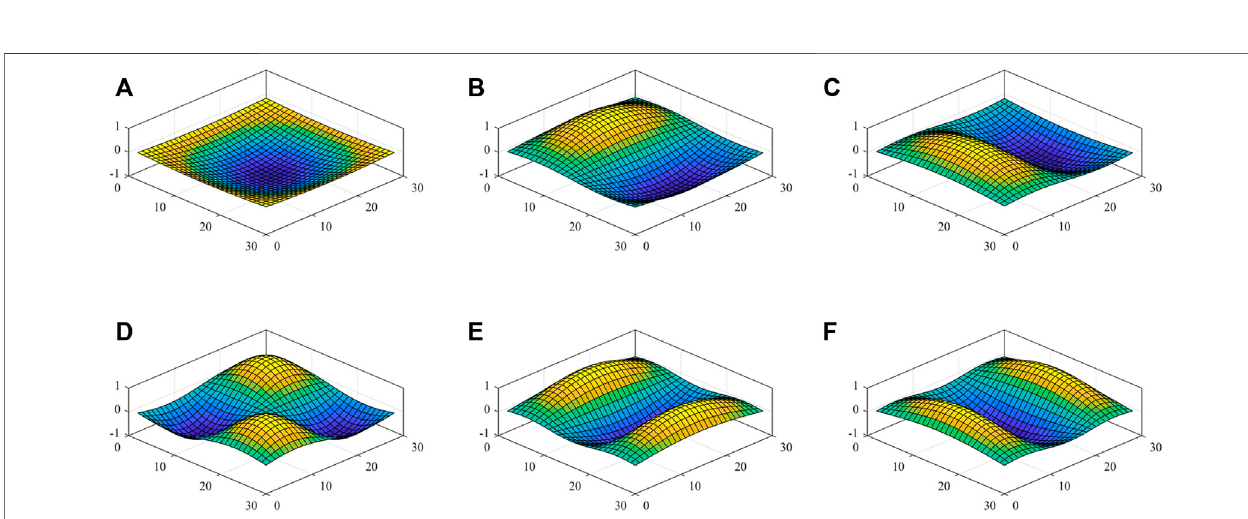
FIGURE3| Firstsixmodesofthepiezoelectric-integratedFGplate(CFFF): (A) fi rstmode; (B) secondmode; (C) thirdmode; (D) fourthmode; (E) fi fthmode;and (F) sixth mode.